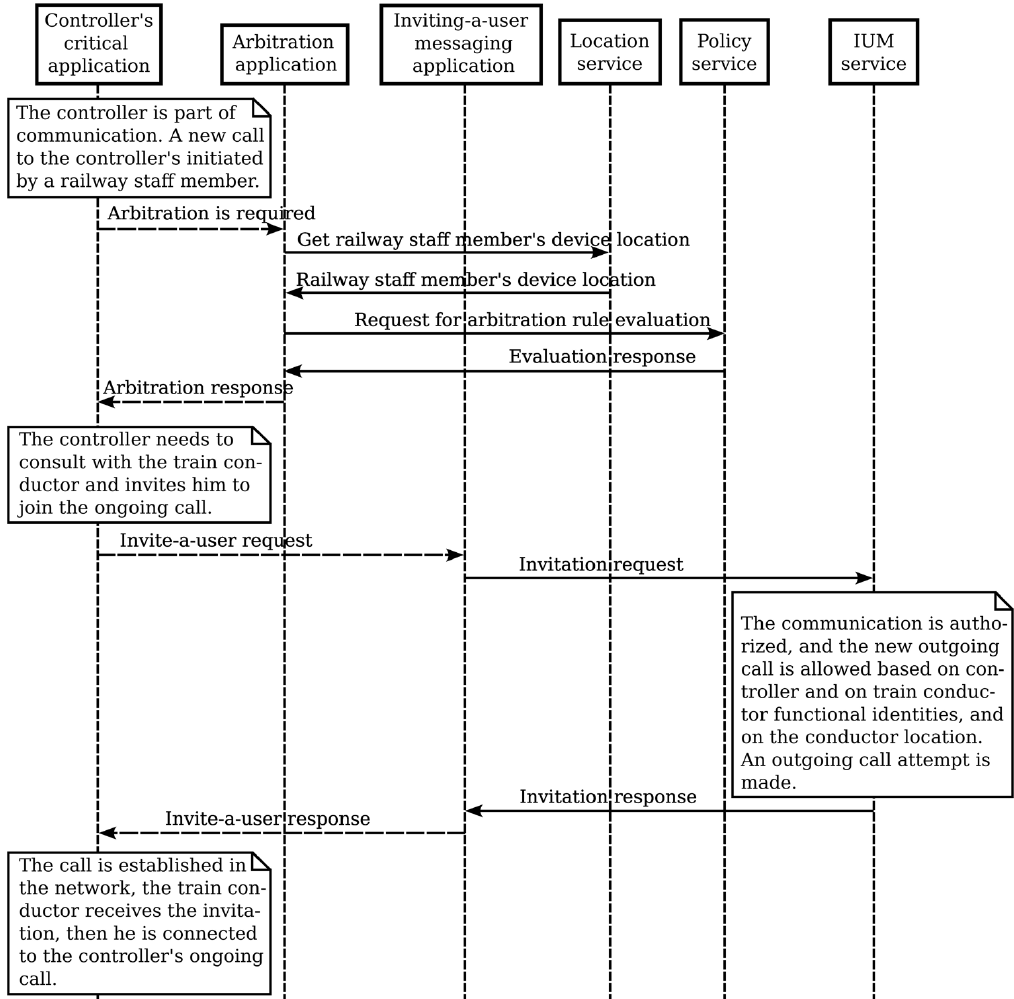
Figure 14. Services interaction flow for arbitration and invite-a-user messaging.